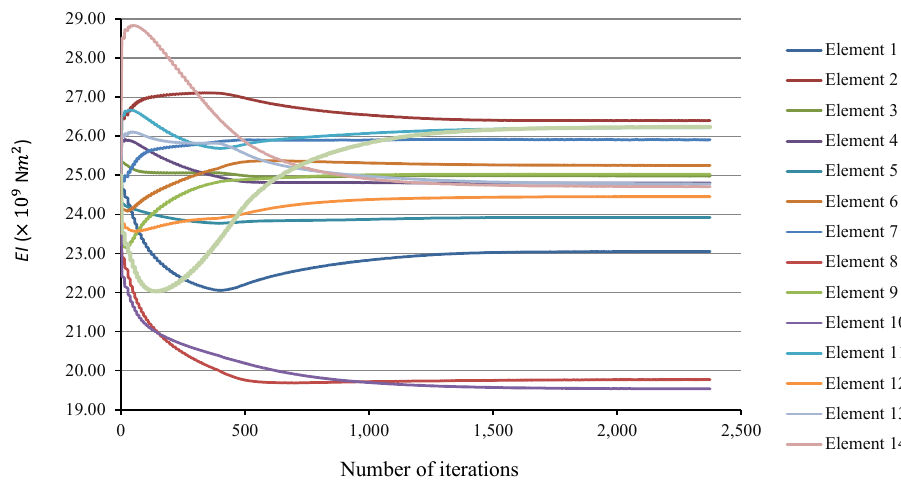
Figure 12. Identification evolution process for structural parameters at 5% noise. Table 9. Identification results for a two-span continuous bridge.